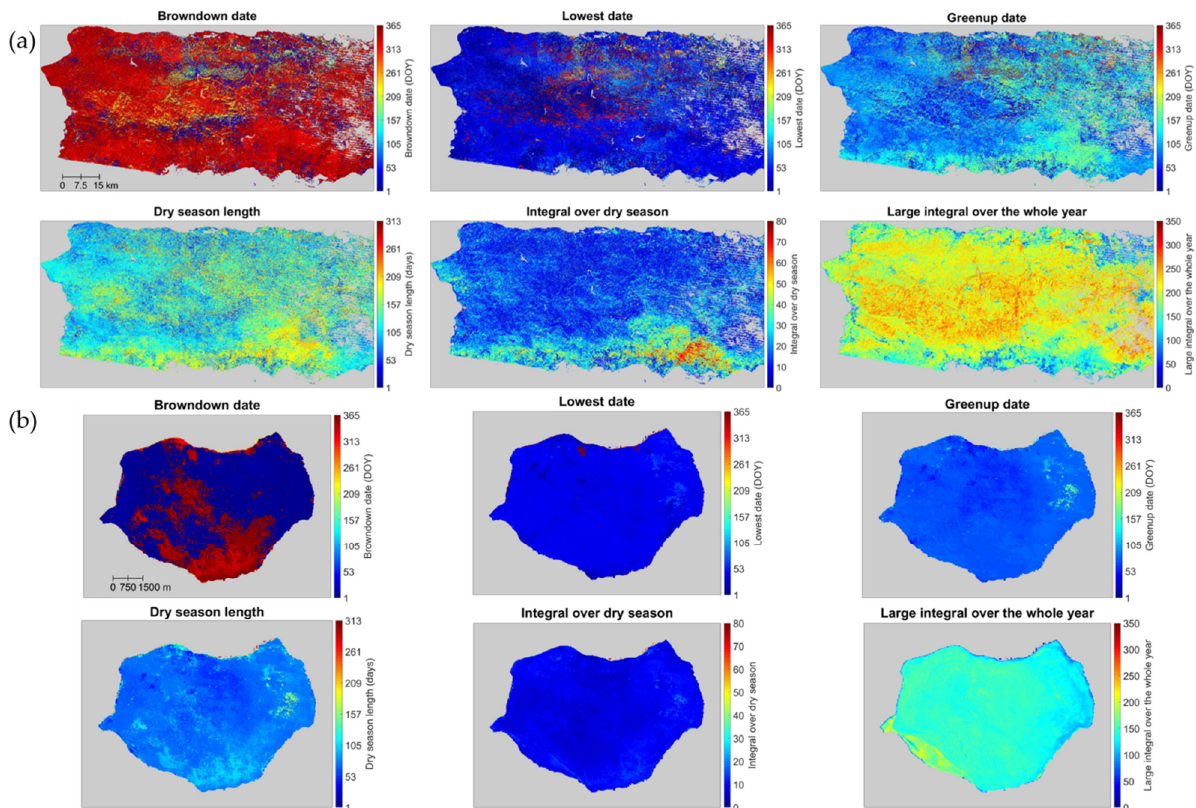
Figure 10. Representative phenology metrics derived from the reconstructed Landsat time series in main island ( a ) and Mona ( b ): browndown date, lowest date, greenup date, dry season length, integral over dry season, and large integral over the whole year. Gray pixels are background, water, and pixels with clear observations fewer than 10 during 2005–2009.